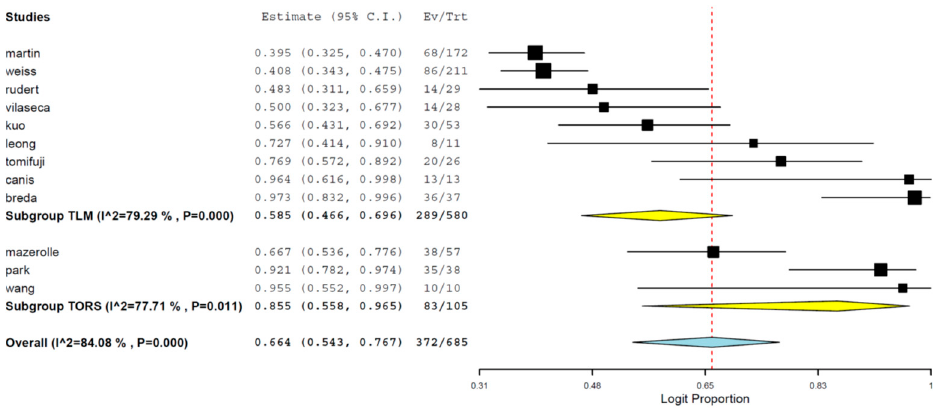
Figure 2. Subgroup meta-analysis including transoral robotic surgery (TORS) and transoral laser microsurgery (TLM) groups regarding overall survival estimates (95% confidence interval (CI)). Ev, events; Trt, treatment.